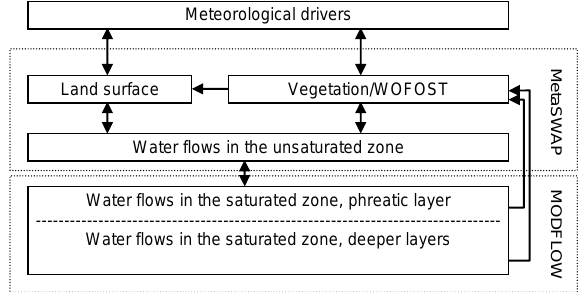
Fig. 1. Overview of SIMGRO modelling framework and attached models used in this study. Figure 1. Overview of SIMGRO modelling framework and attached models used in this 2 study. 3